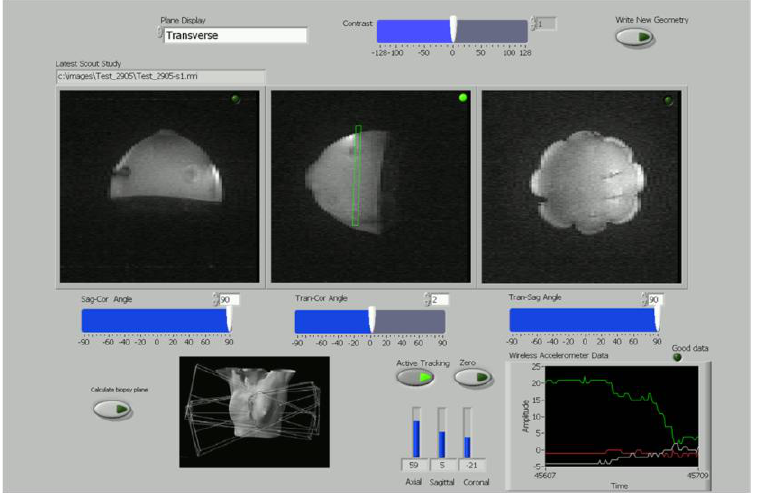
Figure 4. A simplified version of the LabView wireless interactive geometry planning software showing three scout images acquired at 0.5T from the breast phantom in axial, sagittal and coronal planes with the planned slice superimposed in green for the